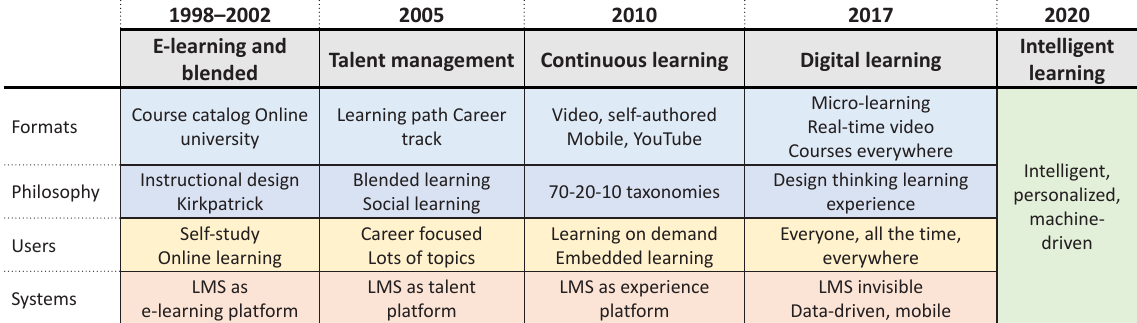
Table 2. The evolution of learning